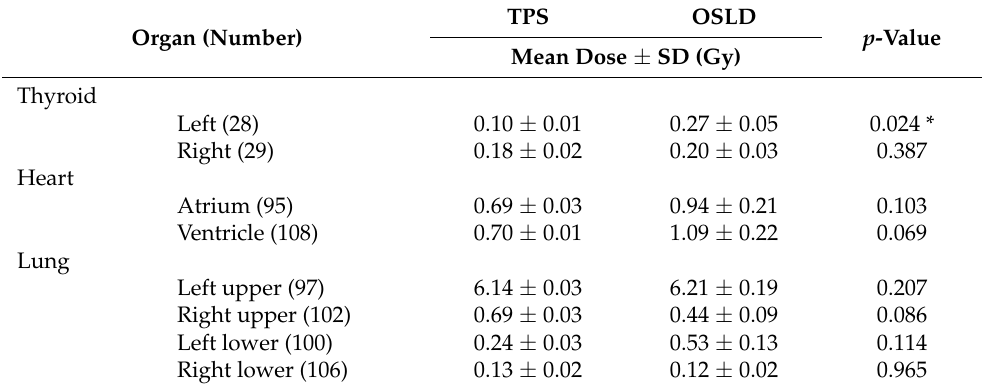
Table 3. Comparison of the TPS calculated doses and the doses measured by OSLDs of the 3D-CRT plan.